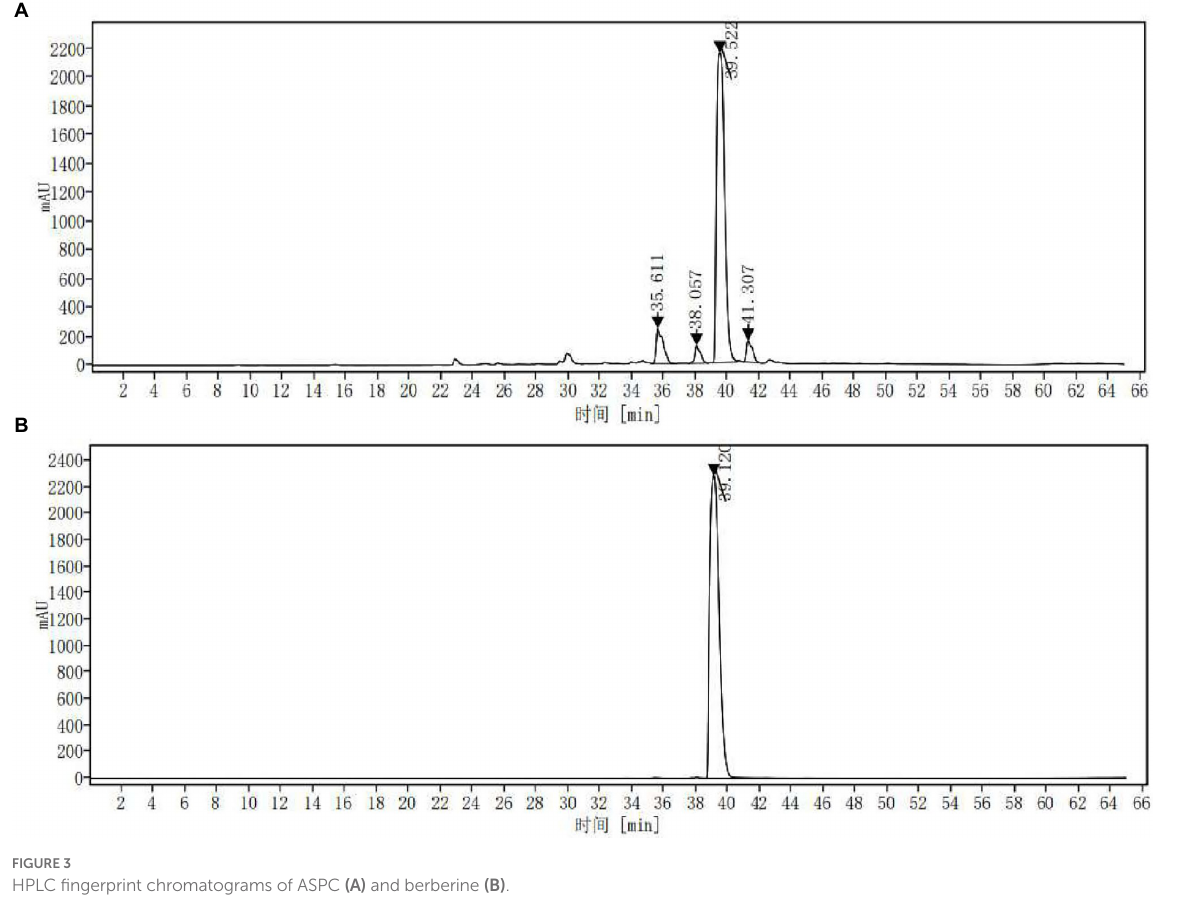
FIGURE 3 HPLC fingerprint chromatograms of ASPC (A) and berberine (B) .